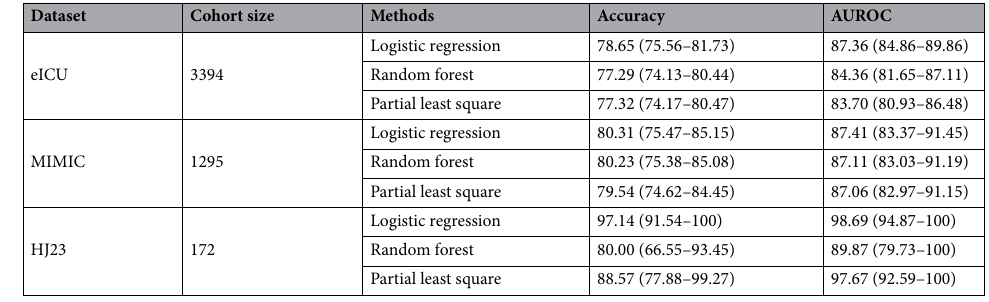
Table 2. Comparison of model performance among the three data sets and statistical approaches. HJ23 had the highest model performance, yet lowest cohort size, while the opposite is true for eICU-CRD. For MIMIC and eICU-CRD, model performance is similar across all three methods. AUROC area under the receiver operator curve. 95% Confidence Intervals are provided in